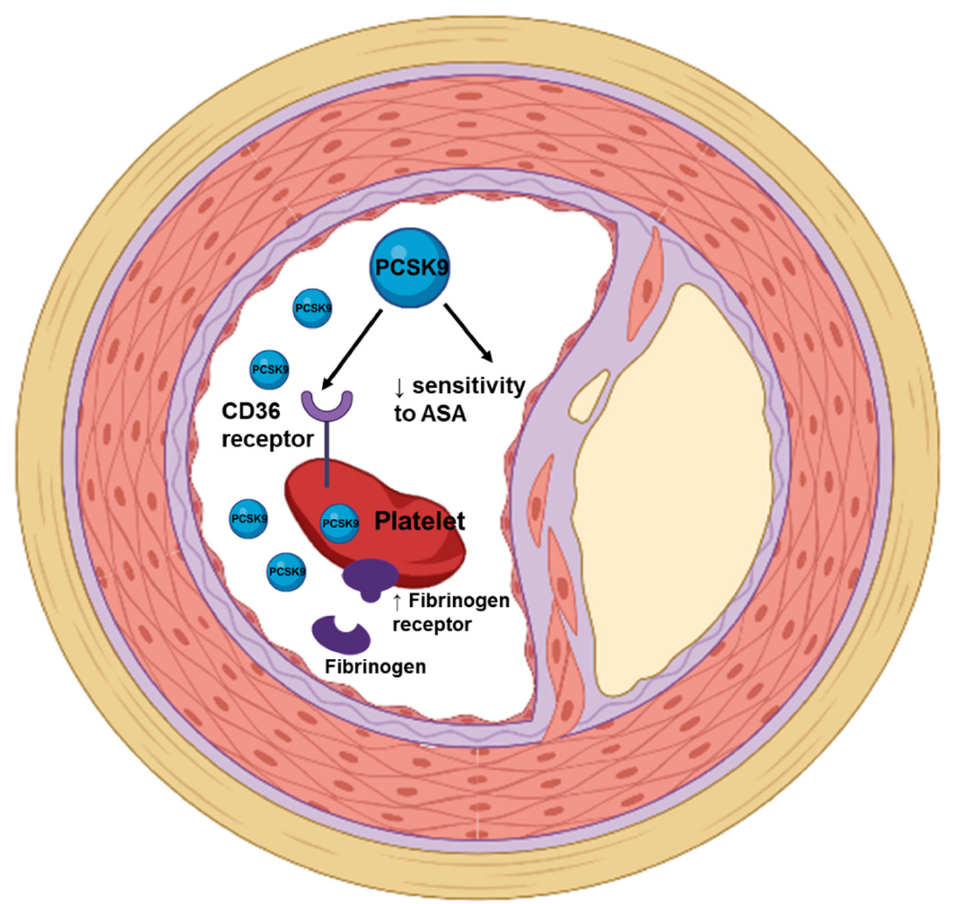
Figure 2. The role of PCSK9 in platelets’ activity. High PCSK9 levels enhance platelet activation and reduce platelet responsiveness to acetylsalicylic acid, thus promoting atherosclerotic events. ASA, acetylsalicylic acid.